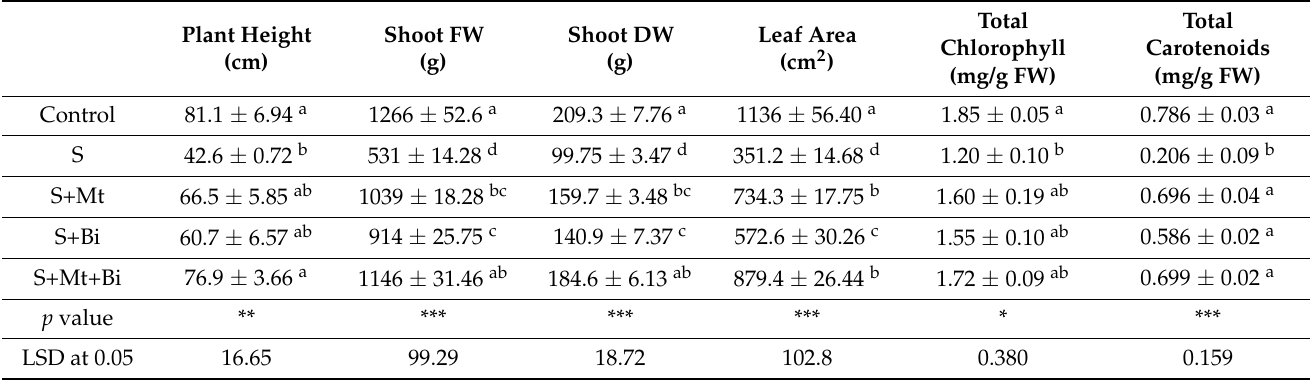
Table 5. The effect of melatonin (Mt) and/or biochar (Bi) supply on plant growth trials and photosyn- thetic pigment concentration of borage plants grown in a saline medium (S, 5000 ppm